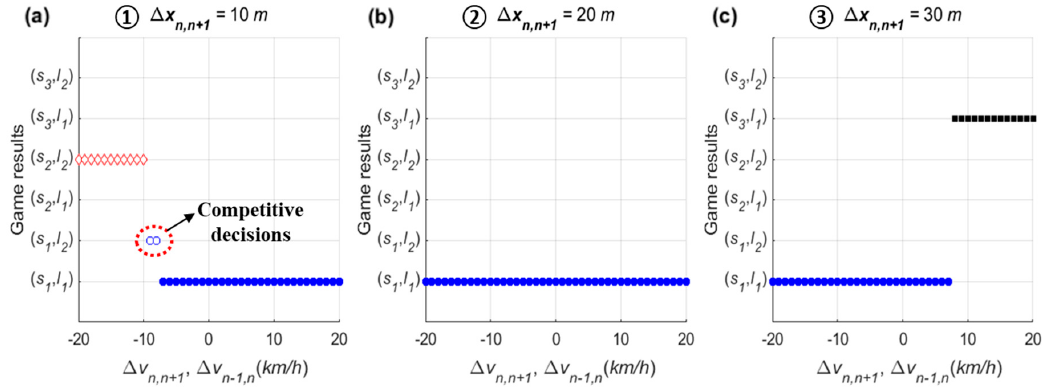
Figure 10. Game results on relative speed: ( a ) ∆ x n , n + 1 = 10 m; ( b ) ∆ x n , n + 1 = 20 m; ( c ) ∆ x n , n + 1 = 30 m.